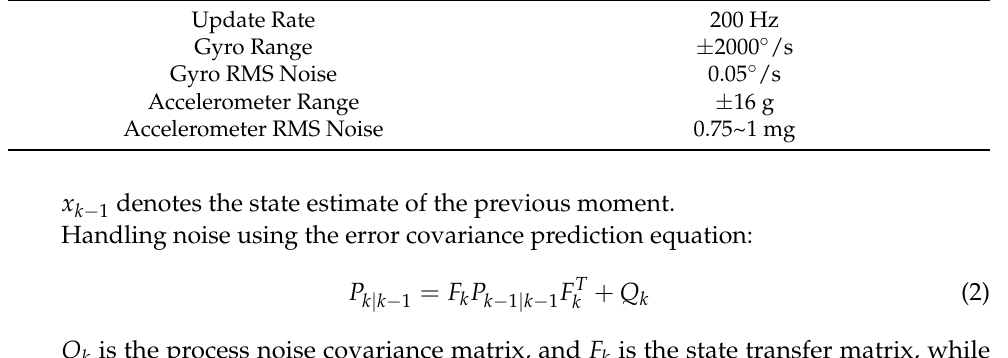
Table 1. INS Parameters.